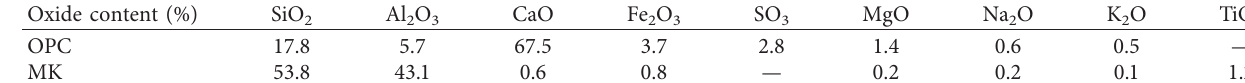
Table 2: Chemical compositions of OPC and MK.